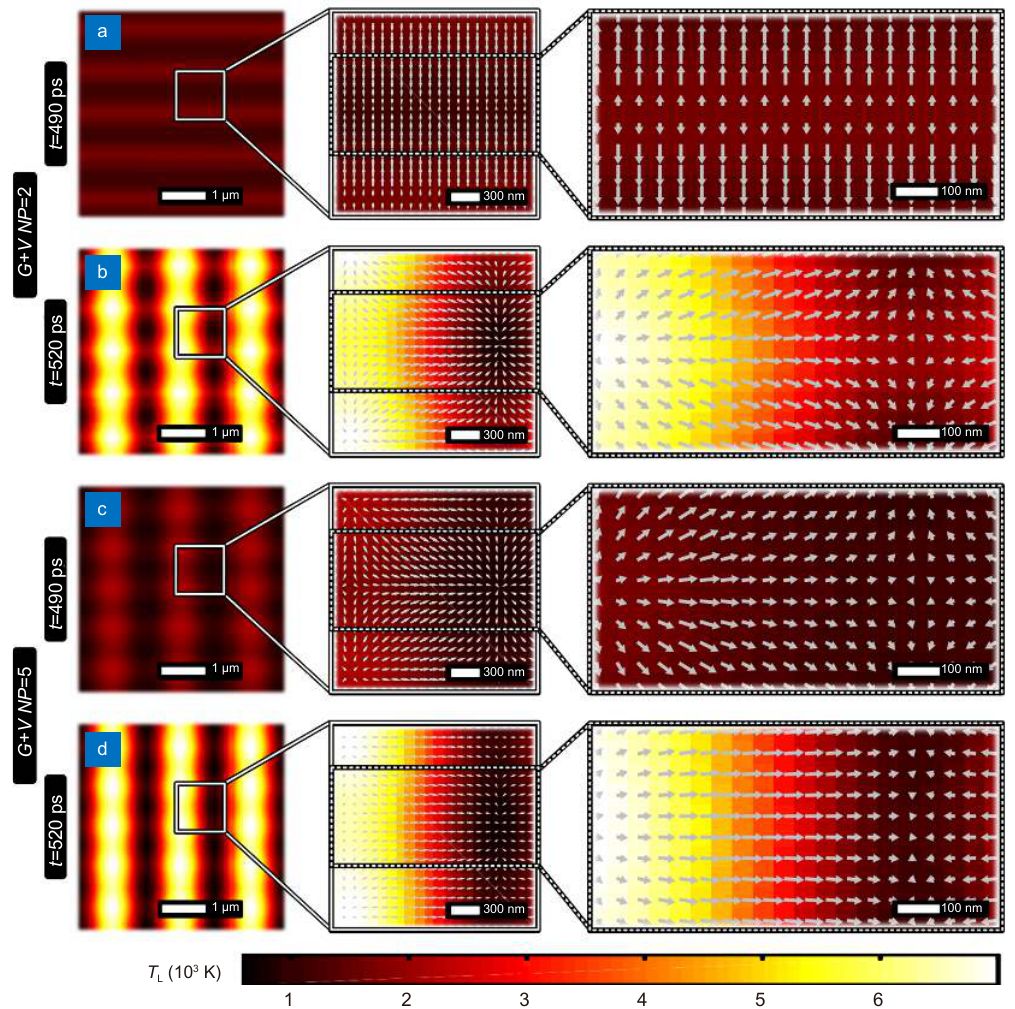
Fig. 7 | Simulation results showing the surface temperature profile obtained for the G + V case at different time moments and NP , as in- dicated . The arrows in the figures in the zoomed regions illustrate the spatial distribution of the magnitude and direction of the calculated fluid ve- locity